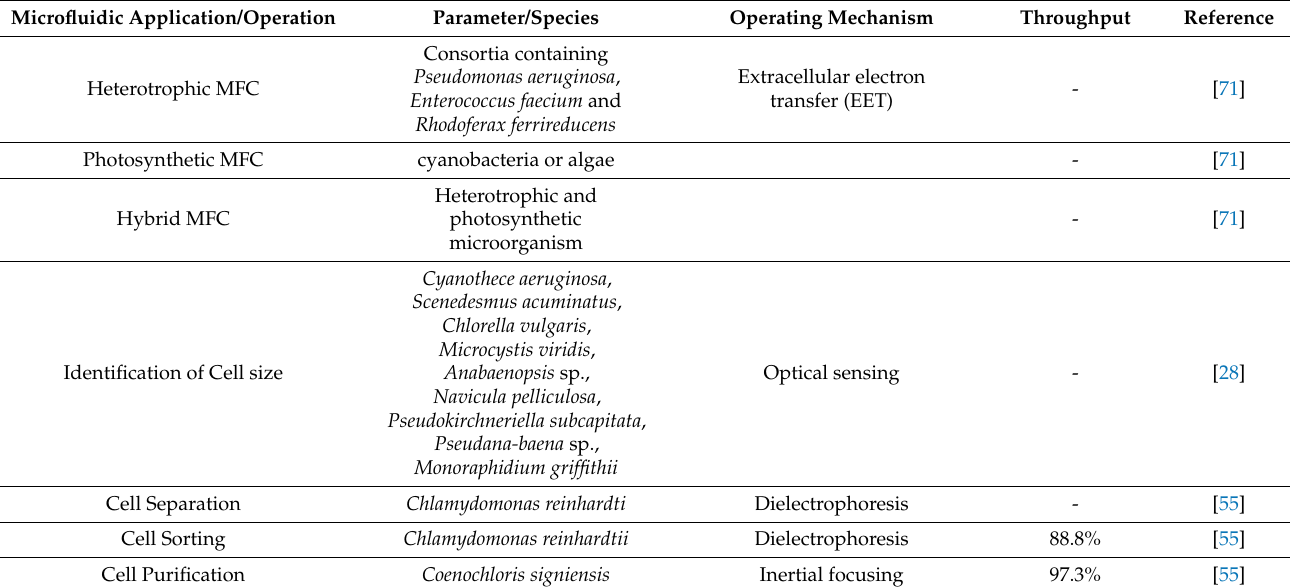
Figure 5. Principle of operations in an MFC. ( A ) Working principle of heterotrophic MFC. ( B ) Working principle of photosynthetic MFC. ( C ) Working principle of hybrid MFC. Reproduced with permission from [71] S. Choi, “Microscale microbial fuel cells: Advances and challenges”, Biosensors and Bioelectronics, 2015. Table 1. Summary of microfluidic operations with their respective